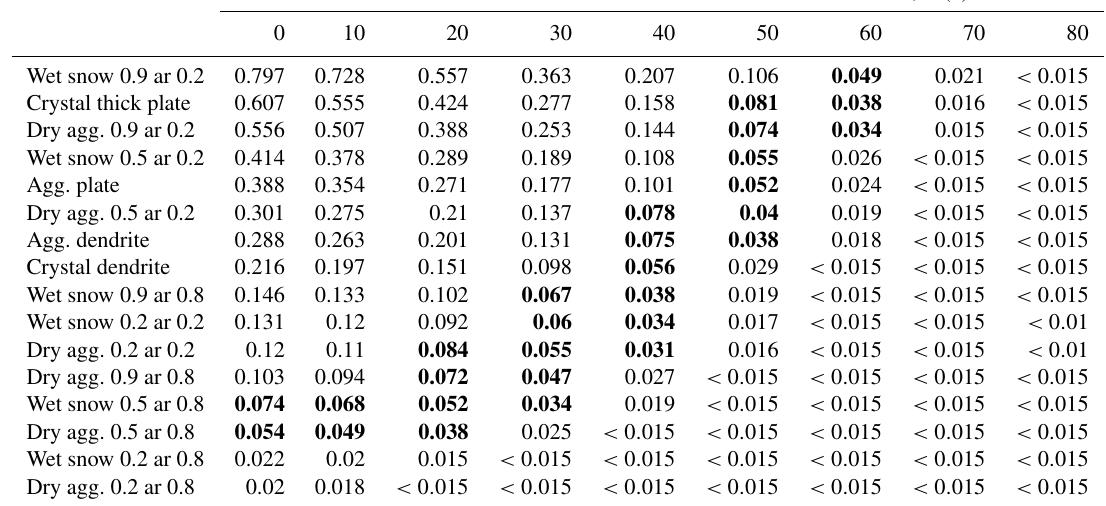
Table 1. Ratio between K dp and IWC for the different hydrometeors shown in Fig. 8 when a certain standard deviation is assumed in the orientation distribution (Gaussian distribution centered at 0 ◦ and σ ), and σ = 0 ◦ represents the scenario in which all particles are horizontally oriented, while for large σ , all particles would be randomly oriented (see Eq. 7). In bold, the ratios within the range [0.03–0.09] are shown, which is in agreement with the observed ratios in Fig.